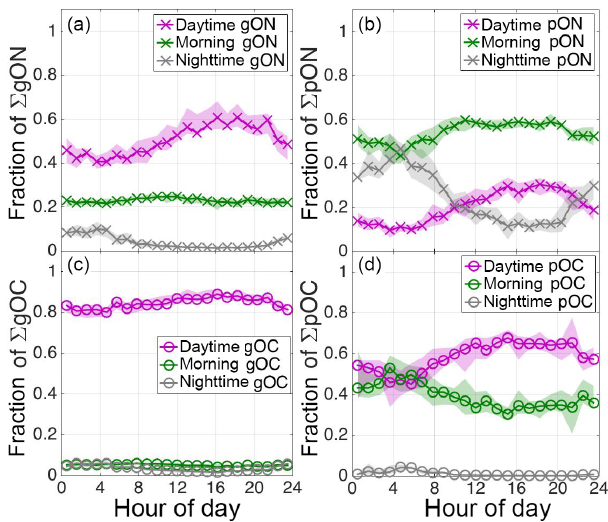
Figure 6. Mass fractions accounted for by the (purple) daytime, (green) morning, and (grey) nighttime subgroups in each of the (a) gON, (b) pON, (c) gOC, and (d) pOC groups, as a function of hour of day. The shaded regions represent the 25th and 75th quan-